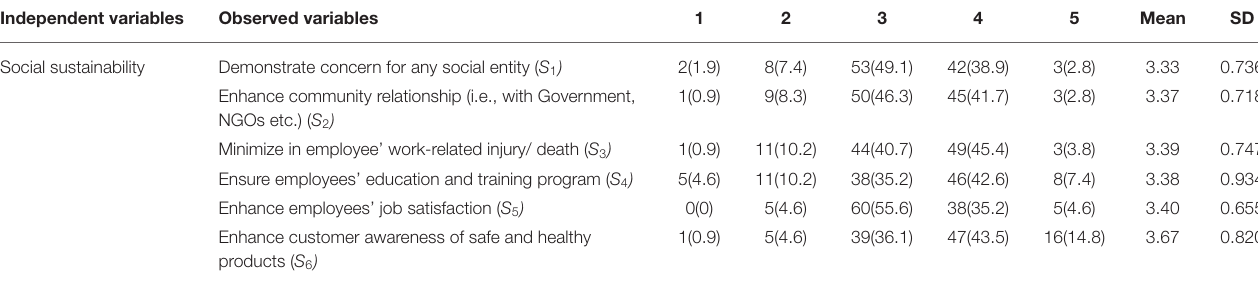
Numbers in bracket represent percentage.